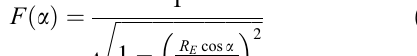
1 ffiffiffiffiffiffiffiffiffiffiffiffiffiffiffiffiffiffiffiffiffiffiffiffiffiffiffiffiffi